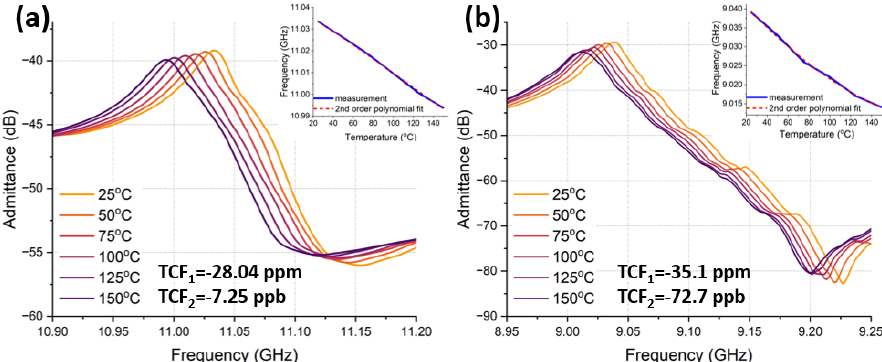
Figure 16. 1st and 2nd order TCF measured for: ( a ) AlN CLMR. ( b ) Al 72 Sc 28 N